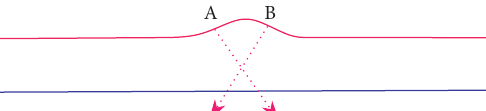
Figure 9: Curves for the example in Section 3.7.3; curve c is blue and curve 􏽥 c is